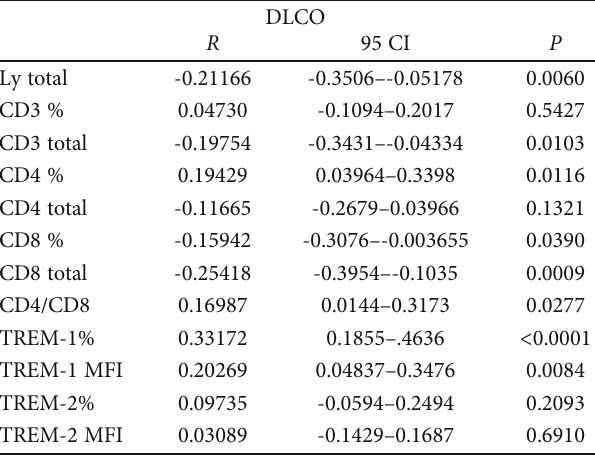
Table 5: DLCO, TREM, and T cell subset correlation analysis. DLCO R